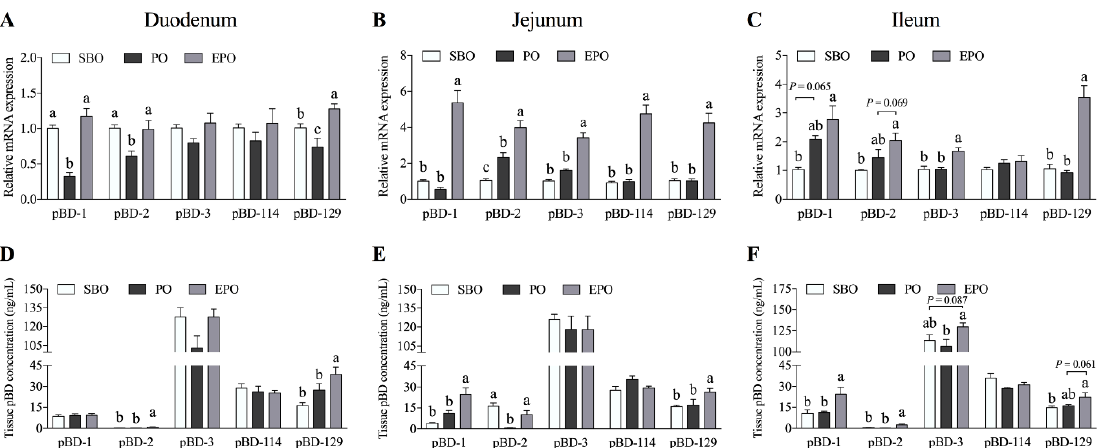
Figure 2. Secretion of β -defensins in the porcine small intestine. The mRNA expression and concentrations of porcine β -defensins in the duodenum ( A , D ), jejunum ( B , E ), and ileum ( C , F ). SBO, soybean oil group; PO, palm oil group; EPO, encapsulated palm oil group. Different letters (a, b, and c) indicate a significant difference among different groups ( p < 0.05).